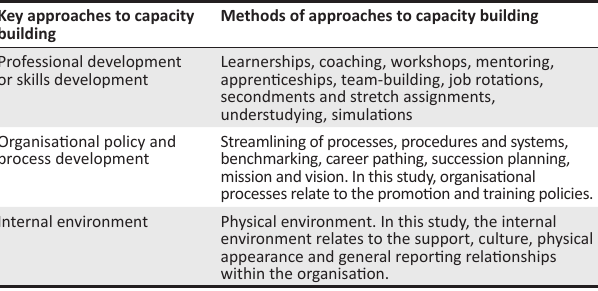
TABLE 1: Approaches to capacity-building and their